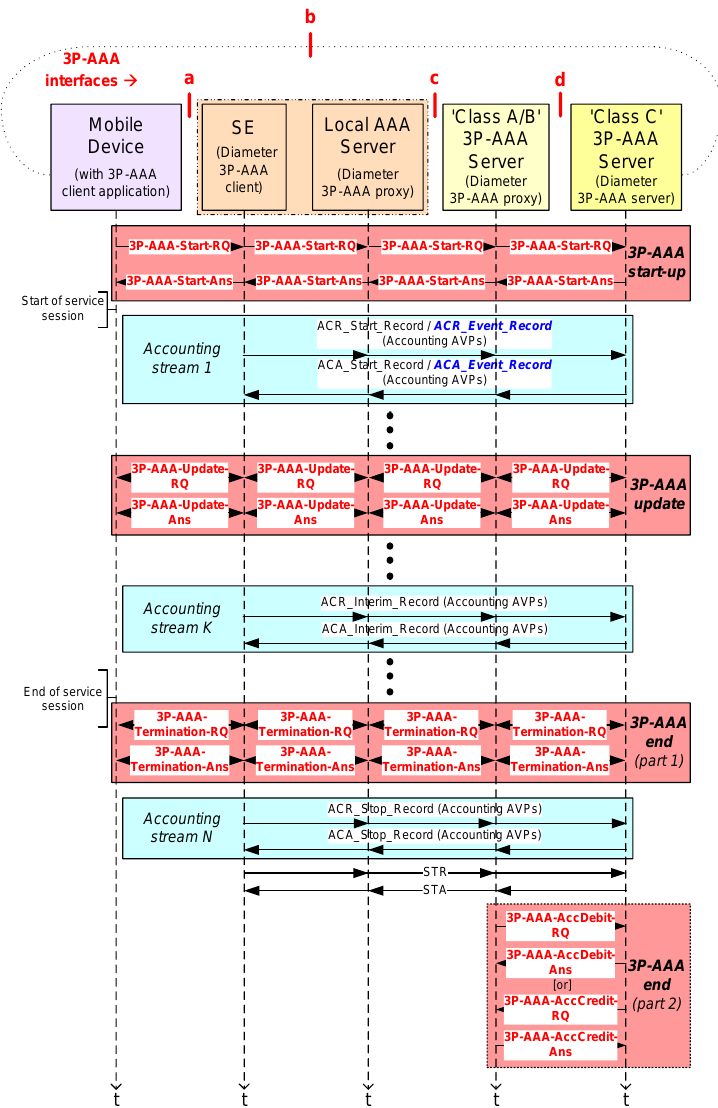
Figure 6. A typical example of the main 3P-AAA signaling traversing the new protocol interface reference points associated with setting up and closing down a single teleservice by utilizing a single network access service without HAC to another ANP (viewing in color is recommended as color- coding is used).